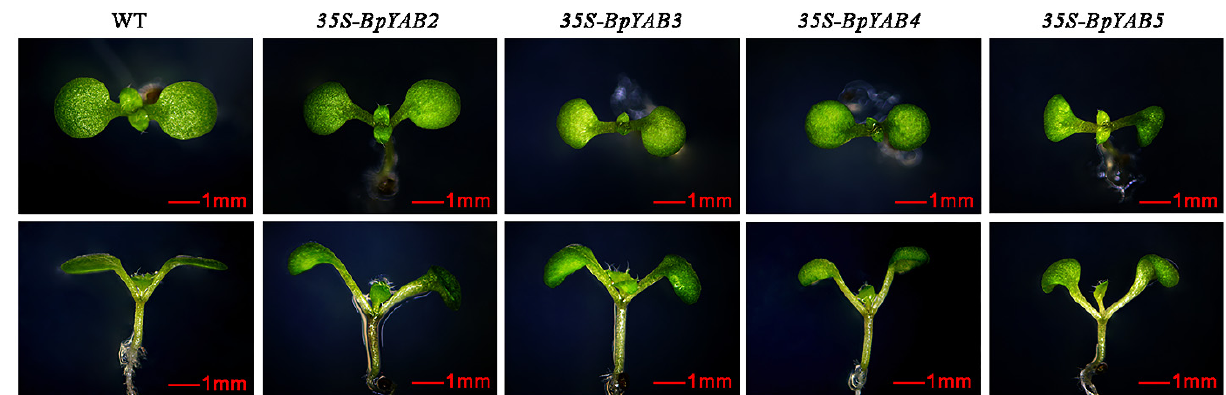
Figure 6. Effects on the morphology of the cotyledon in A. thaliana by ectopic overexpression of BpYAB2 , BpYAB3 , BpYAB4 , and BpYAB5 . The first row of photos shows the top view, and the second row of photos shows the side view.